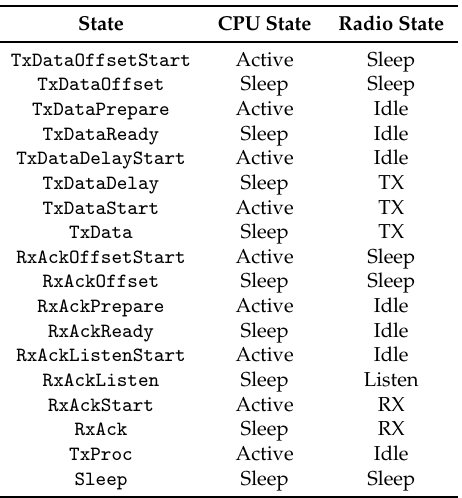
Table 1. States in a TxDataRxAck